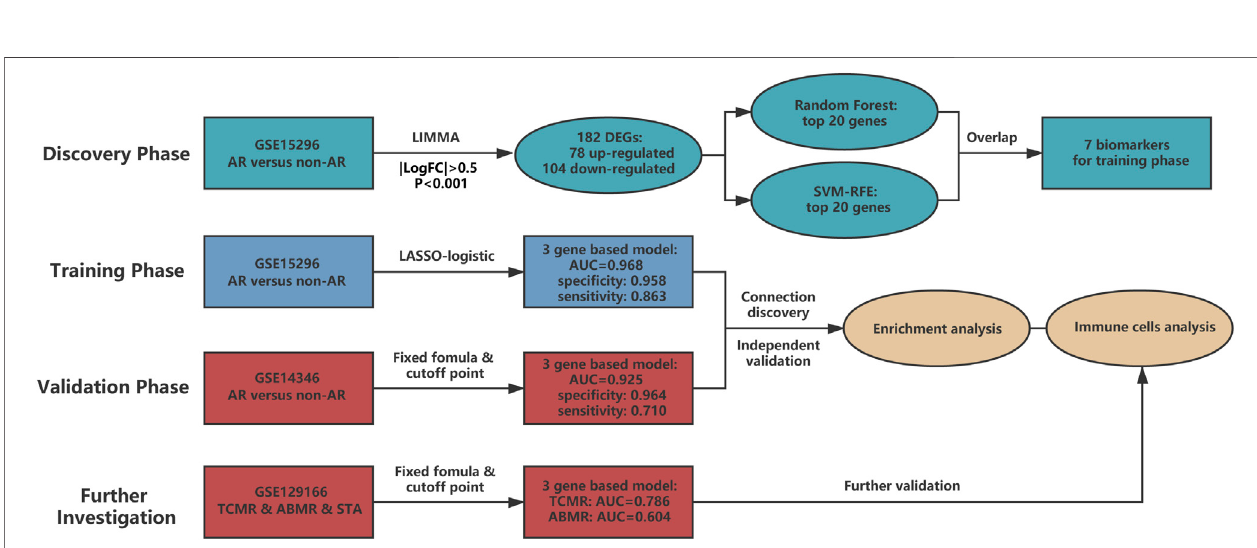
FIGURE1| FlowchartofGEO datasetsselection.AftersystematicallyscreeningtheGEOdatabase,twocohortscomprisinggeneexpressionpro fi lesofmorethan 50 peripheral blood samples with biopsy-proven AR or non-AR were included for analysis. AR: acute rejection.